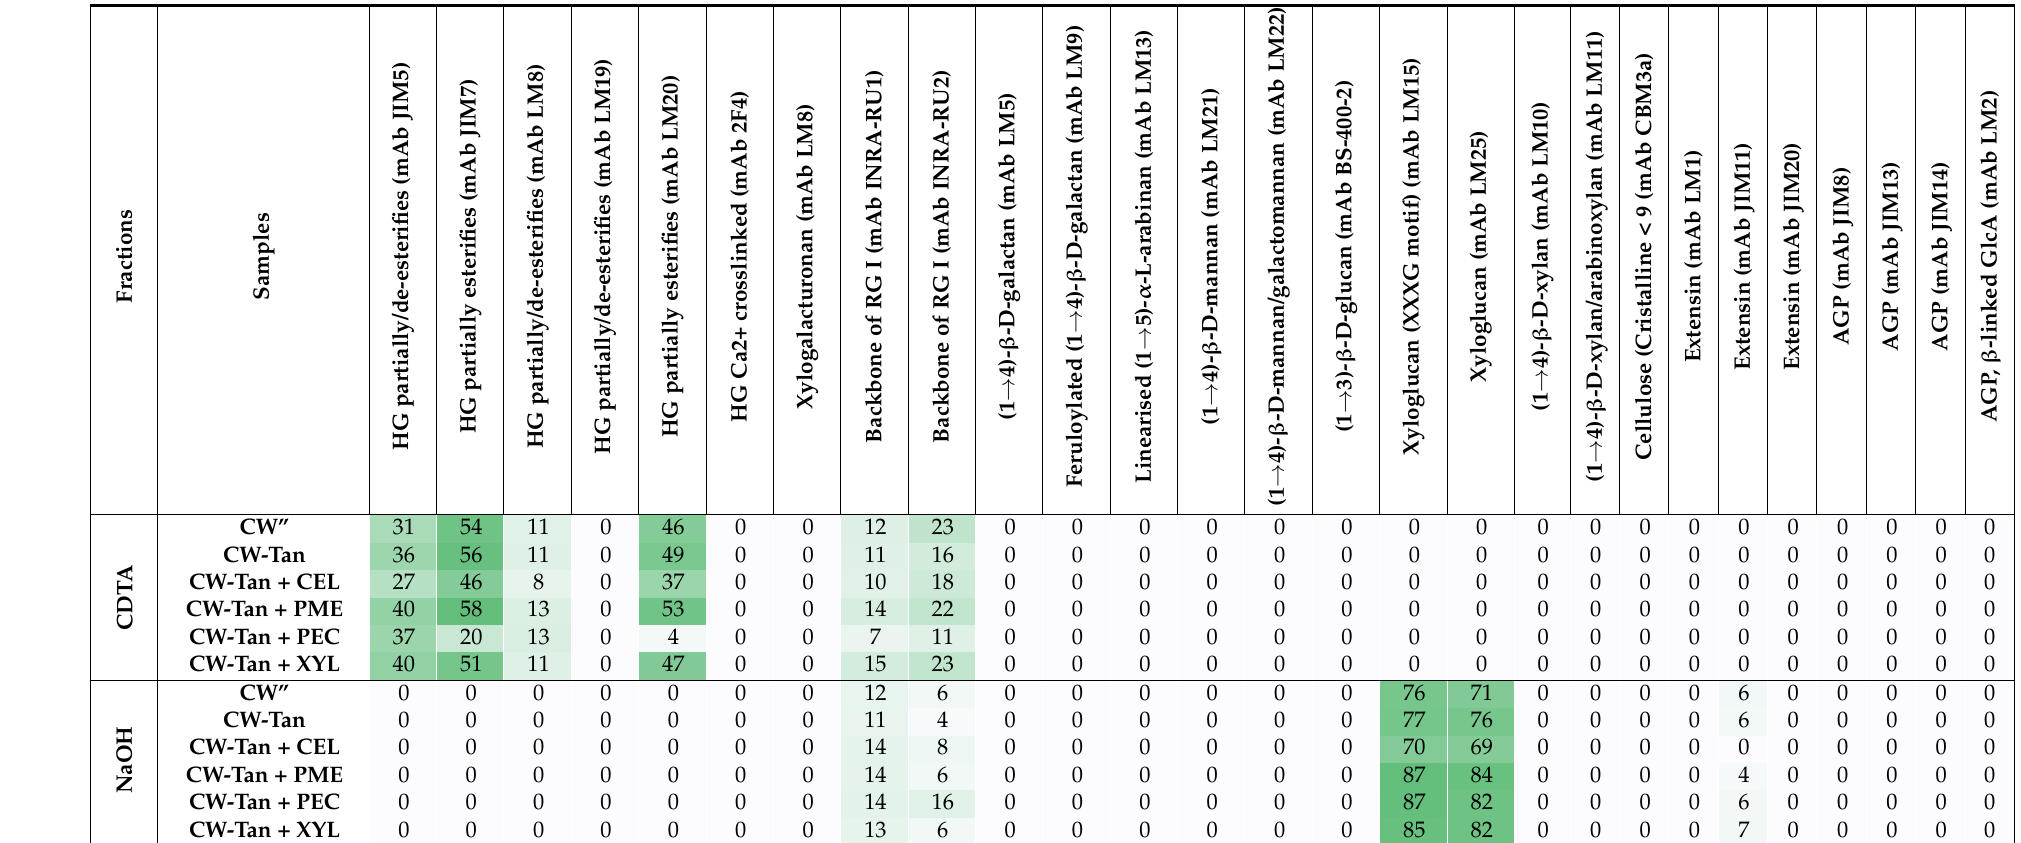
Table 4. Heatmap of epitope abundance (0–100) found in the pectin (CDTA) and hemicellulose (NaOH) fractions extracted from the grape skin cell walls treated (CW”) after interaction with a tannin in the absence or presence of enzymes added individually to grape cell walls in a desorption test.